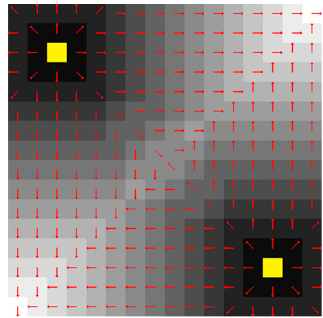
Figure 2. Two lower wavefronts started from the newly blocked cell denoted as yellow tiles.